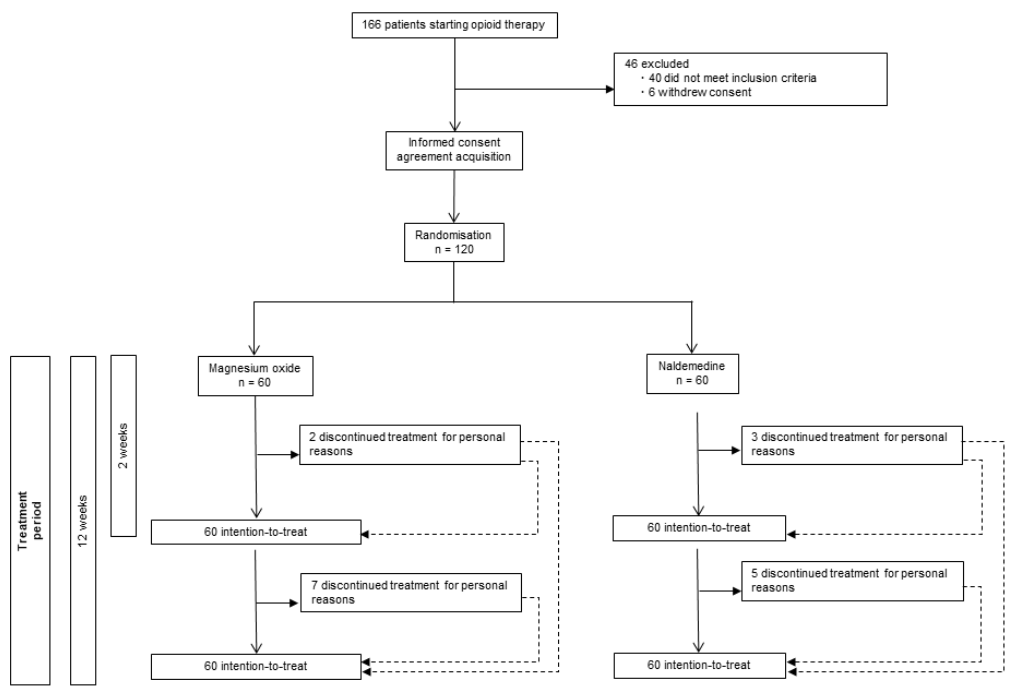
Figure 1. Flow chart showing the study outline.